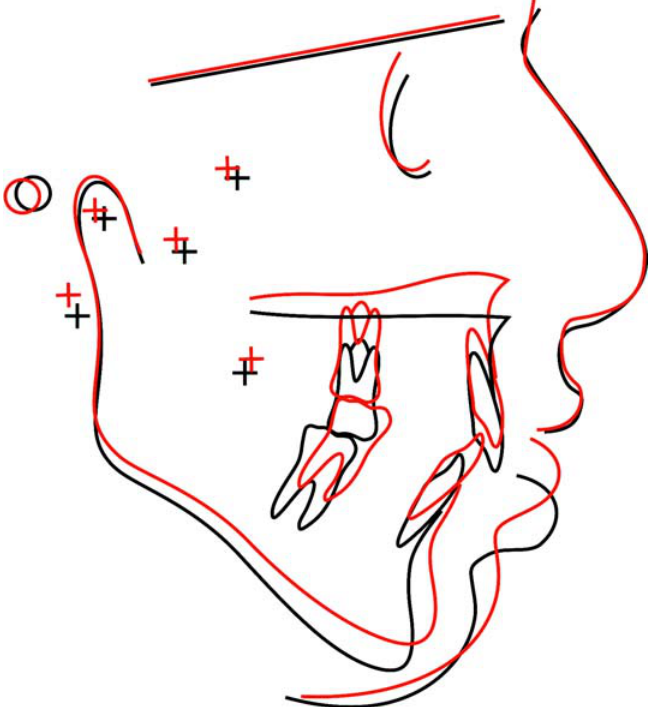
FIGURE 9- Superimpositions of initial and final tracings (black: pretreatment; red: